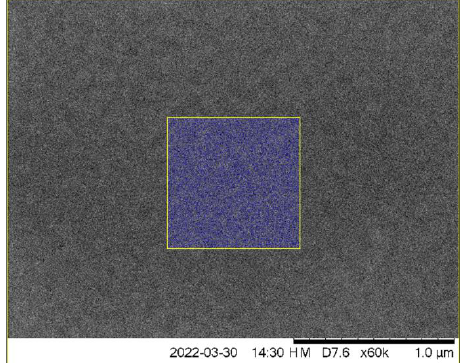
Figure 1. Back-scattered electron SEM image in plan-view or top-down geometry (black & white) with overlaid X-ray map (coloured inset; blue represents Ga and yellow In L-line intensities) of nominally 1.5 ML InAs on GaAs(001). Reproduced from [30].